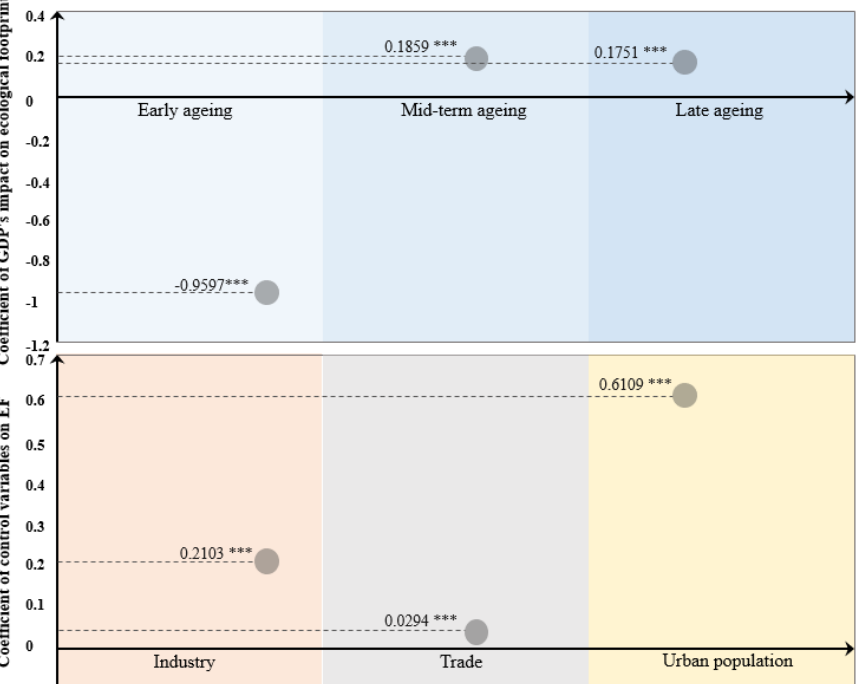
Figure 2. Graph of the influence coefficient of each variable in the global panel data on the ecological footprint. Note: *** represent p -values significant at the 1% level of significance